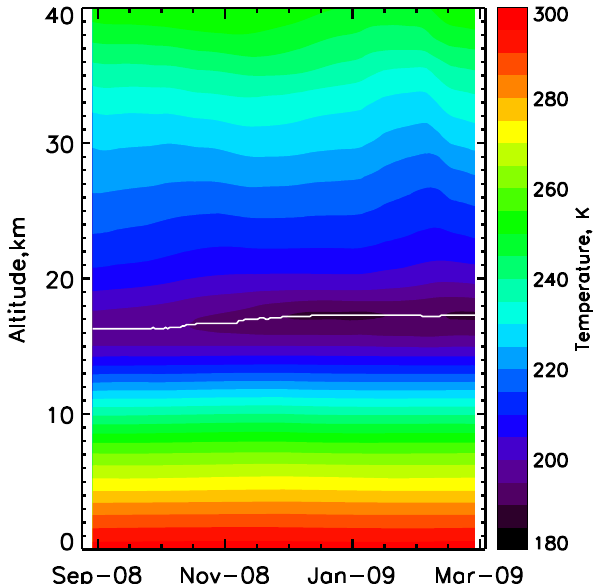
Fig. 2. Variation of 31-day median temperature during Septem- ber 2008 to February 2009. The white dashed line at ∼ 16–17km shows the